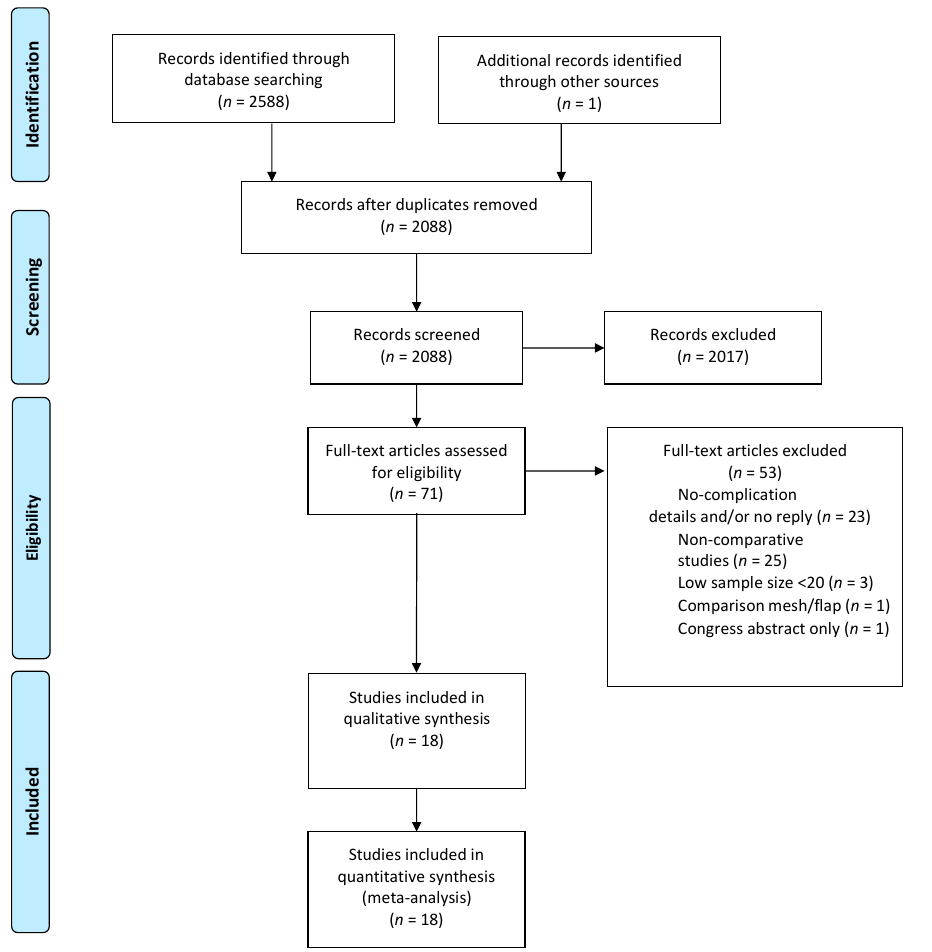
Figure 1. Flow diagram showing the search strategy for articles included in the systematic review and meta-analysis reported following the Preferred Reporting Systems for Systematic Reviews and Meta-Analysis statement.